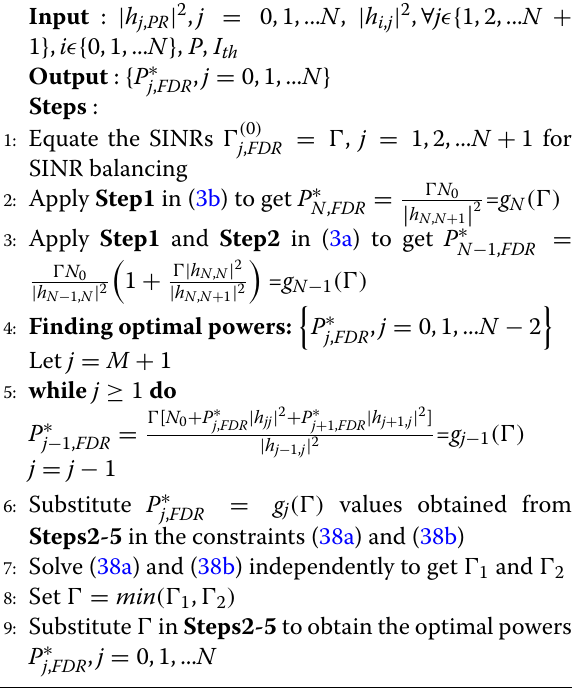
Algorithm 1 Procedure for power allocation : Multi-hop CogFDR